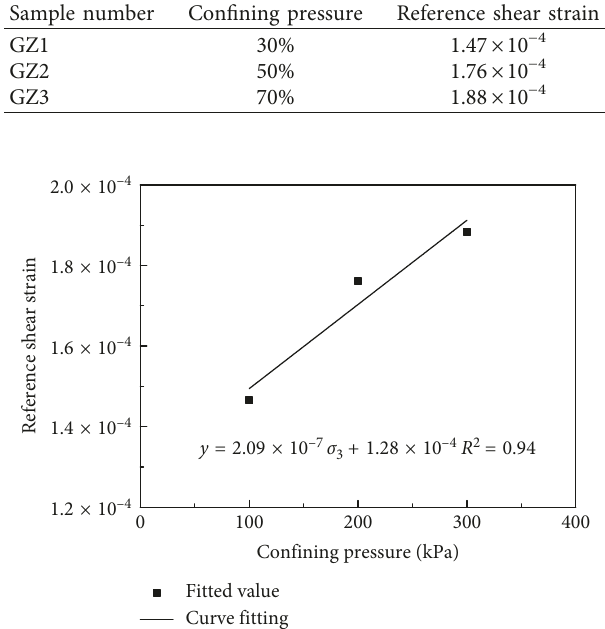
Figure 12: Fitted curves between reference shear strain and confining pressure.